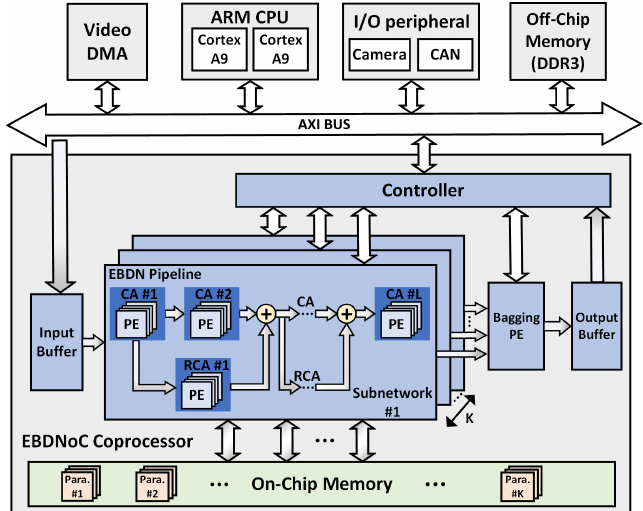
Figure 5. The overall architecture of EBDNoC, which mainly consists of two ARM cores, a neural network co-processor, and other peripherals. EBDNoC co-processor uses several Parallel pipelines to complete the ensemble calculation of the EBDN model. The bagging PE is in charge of aggregating the parallel outputs of